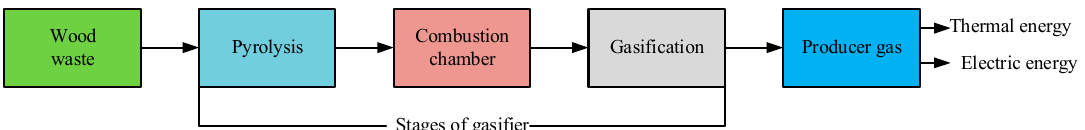
Figure 1. A diagram of a multi-stage gasifier.